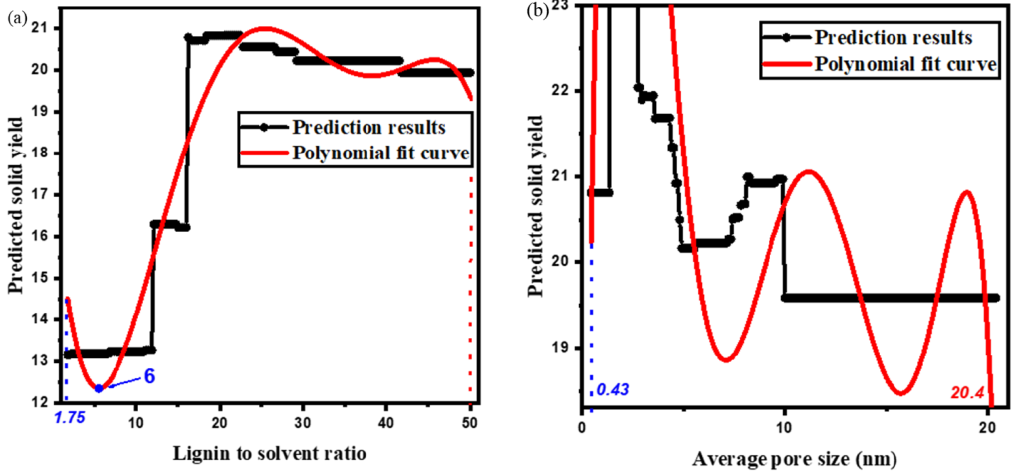
Figure 8. Predicted solid yield of designed lignin-to-solvent ratio (a) and average pore size (b).